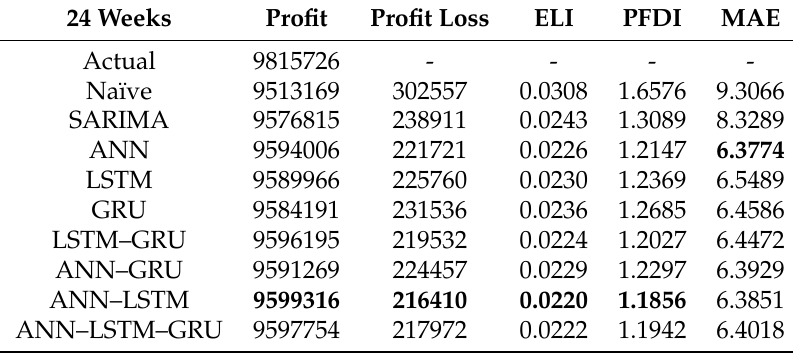
Table 2. Results of the Hydro-based GenCo’s Self-Scheduling According to Various Forecast Methods for 24 weeks.